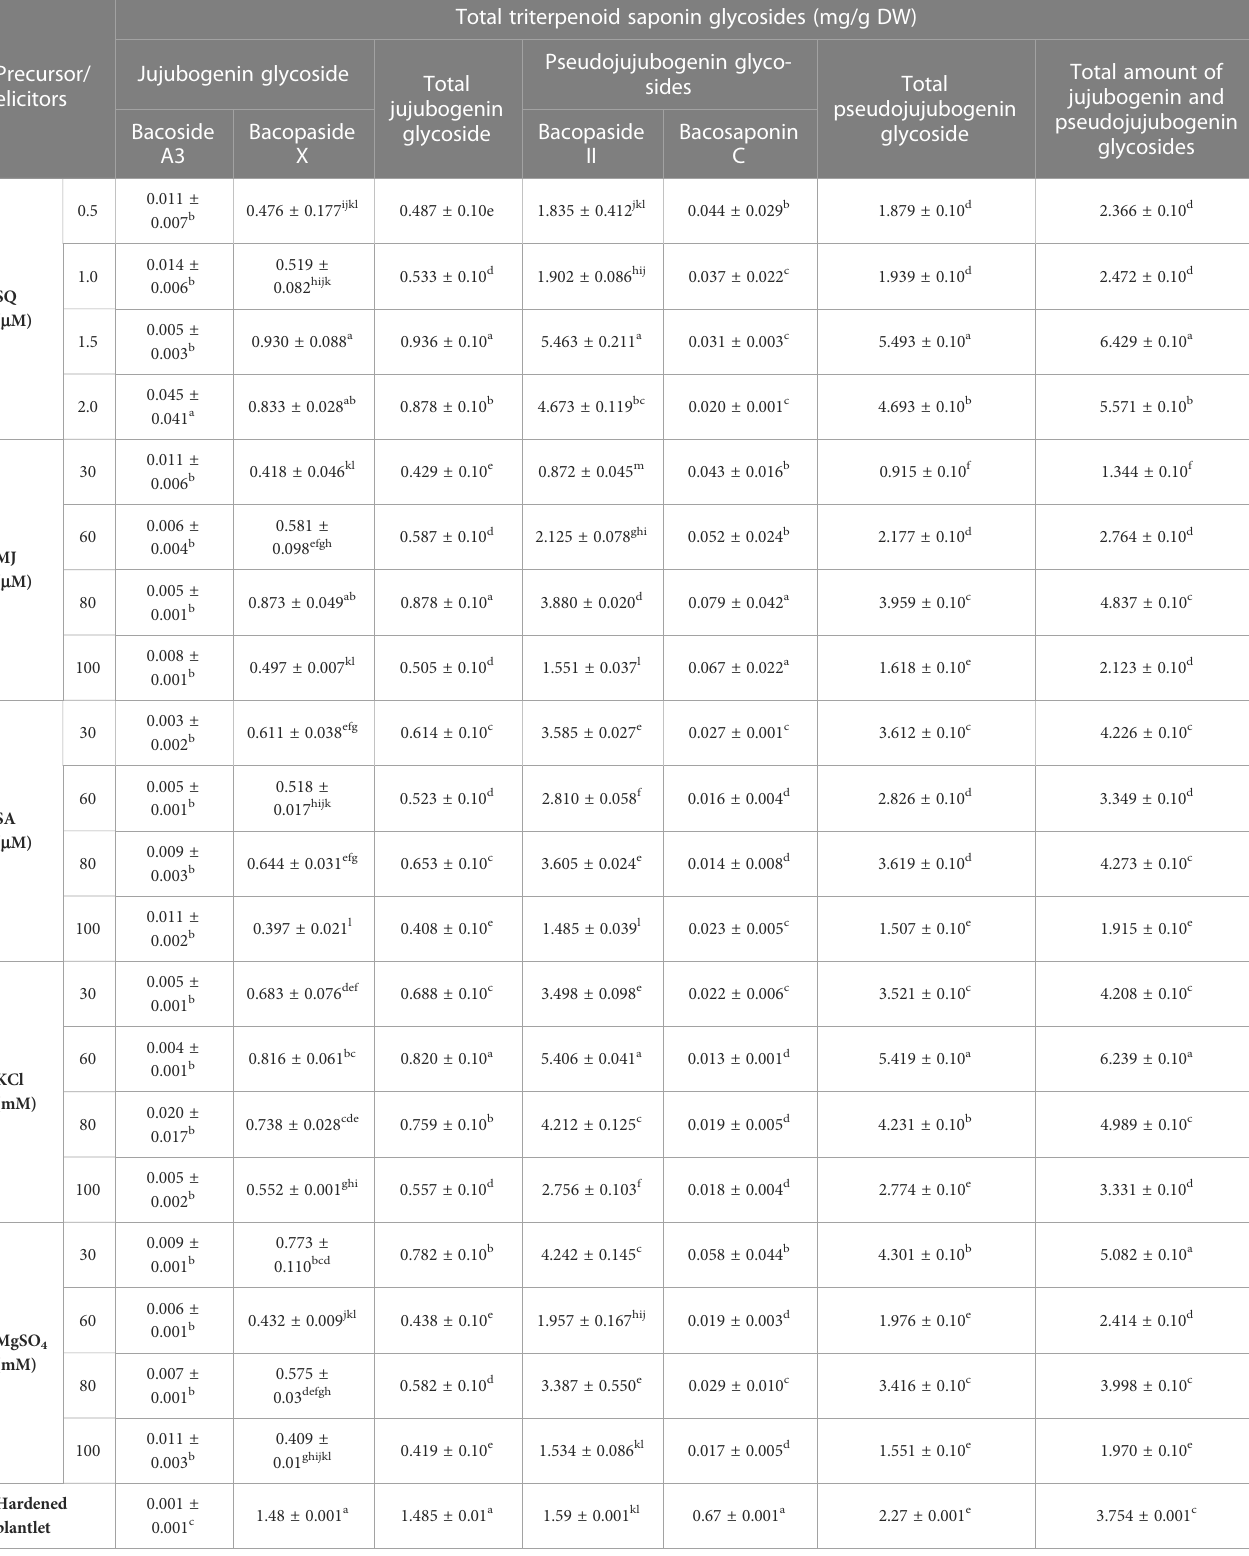
Values represent the averages and standard errors of three independent measurements. According to Duncan ’ s multiple-range test, mean values in the same column with various alphabets exhibited statistically signi fi cant